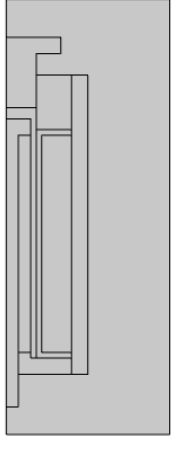
Figure 3. GMA geometric model.